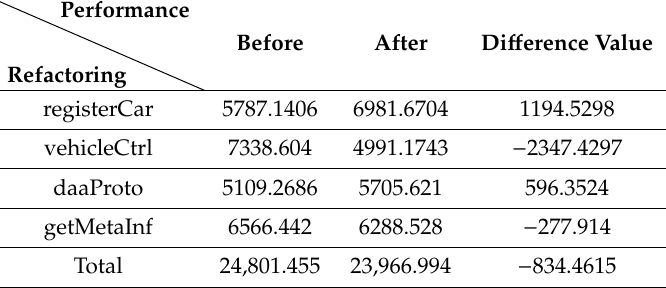
Table 7. Performance measurement